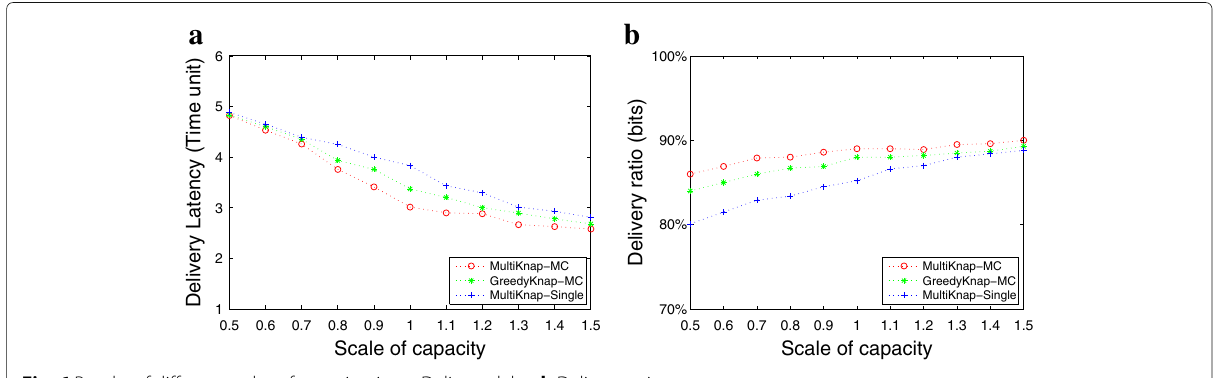
Fig. 6 Results of different scales of capacity size. a Delivery delay. b Delivery ratio